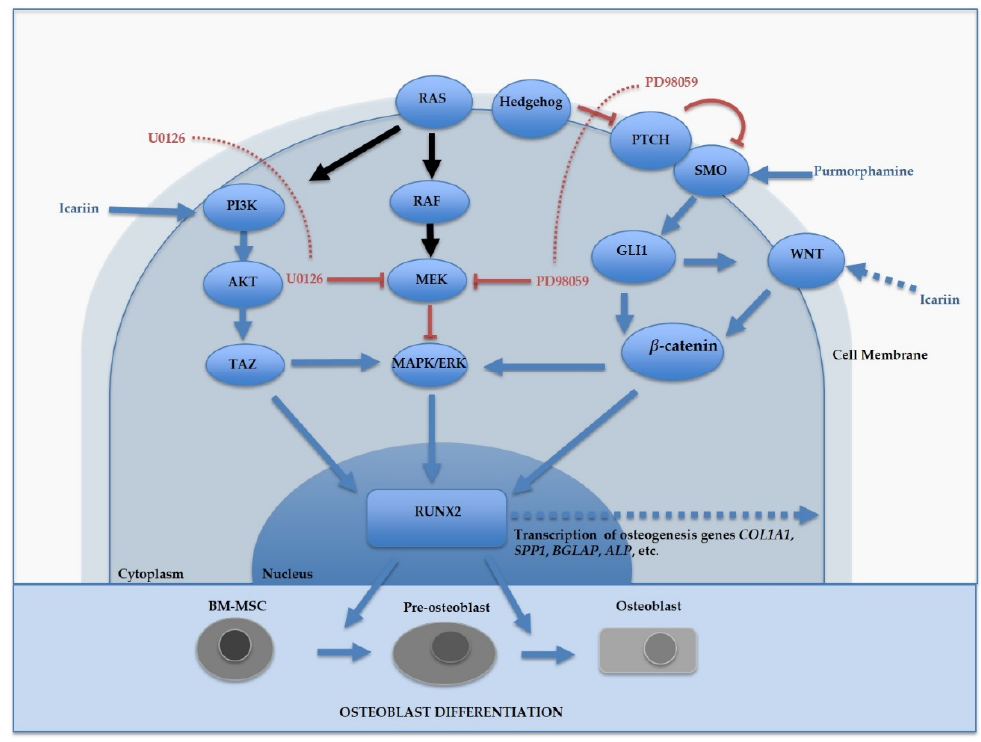
Figure 5. The effect of Icariin, Purmorphamine, U0126, and PD98059 on osteogenic signaling pathways. Icariin activates PI3K / Akt, promoting downstream RUNX2 expression and osteogenic lineage commitment. Purmorphamine stimulates Smoothened (Smo), activating the Hedgehog (Hh) signaling pathway, resulting in the upregulation of its downstream target gene GLI1 , as well as the Wnt / β -catenin signaling pathway, leading to bone formation and the promotion of osteogenic lineage commitment. Icariin also regulates osteogenic commitment via the Wnt / β -catenin pathway. U0126 and PD98059 act as MAPK / ERK mitogen activated kinase (MAPK) inhibitors, resulting in inhibition of osteogenic lineage